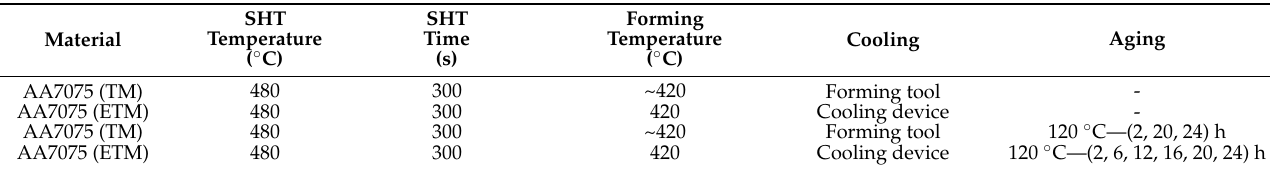
Table 2. Experimental parameters for the investigation of the forming process. TM: thermo-mechanical process. ETM: emulated thermo-mechanical process.